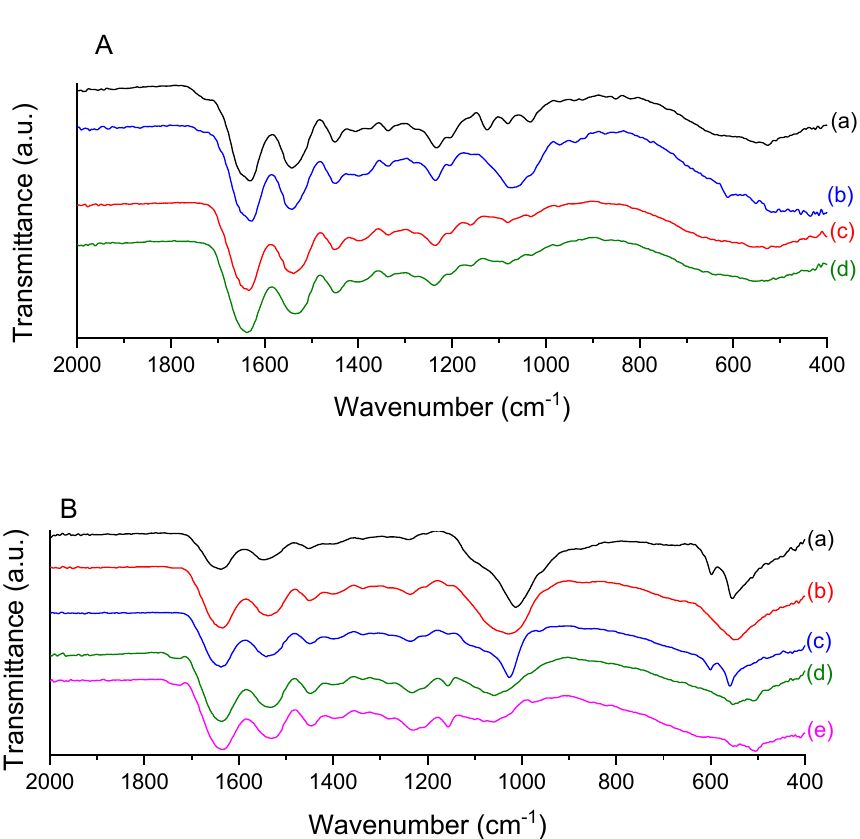
Figure 3. FTIR spectra of ( A ) collagen and phosphorylated collagen scaffolds: (a) C; (b) CP; (c) C10P; and (d) C30P, and ( B ) mineralized scaffolds: (a) CP25; (b) C10P25; (c) C10P37; (d) C30P25 and (e) C30P37.